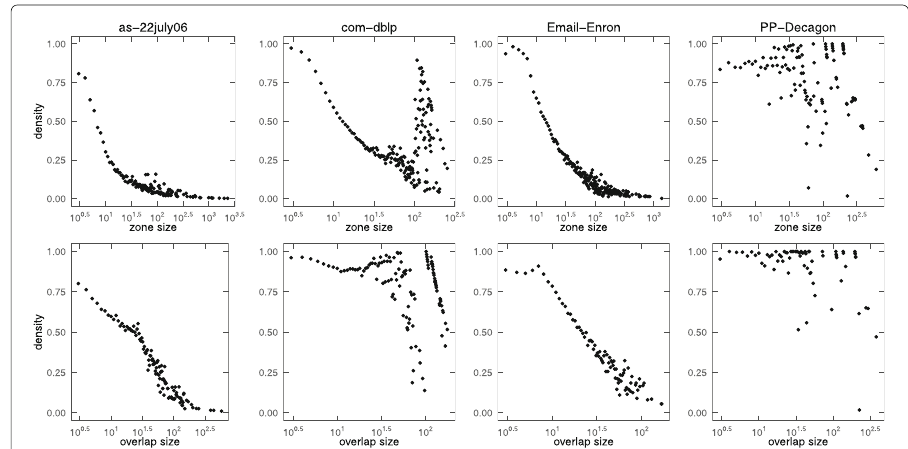
Fig. 14 Density of zones and overlaps in real-world networks. When comparing densities for zones in the upper row and overlaps with the same size in the lower row, it can be noticed that the density of the overlaps tends to be higher than the density of zones of the same size. For other real-world networks see Figs. 25 and 26 in Appendix C